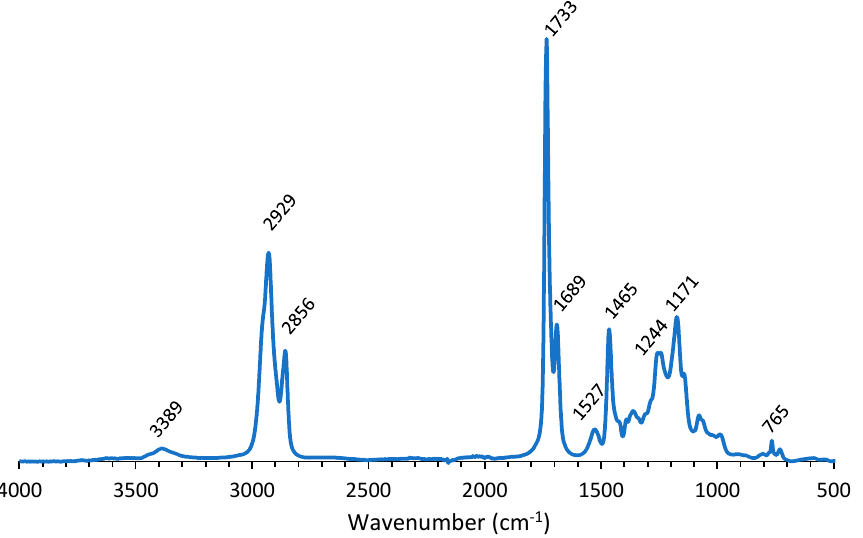
Figure 2. IR spectrum of bio-based PU coating. Table 1. Overview of functional groups in bio PU detected by